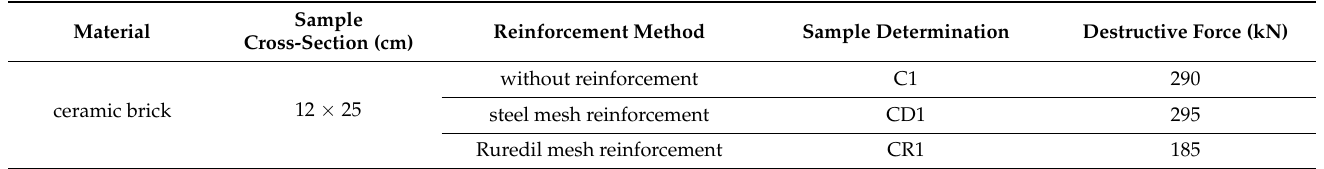
Table 1. Characteristics of tested wall segments.